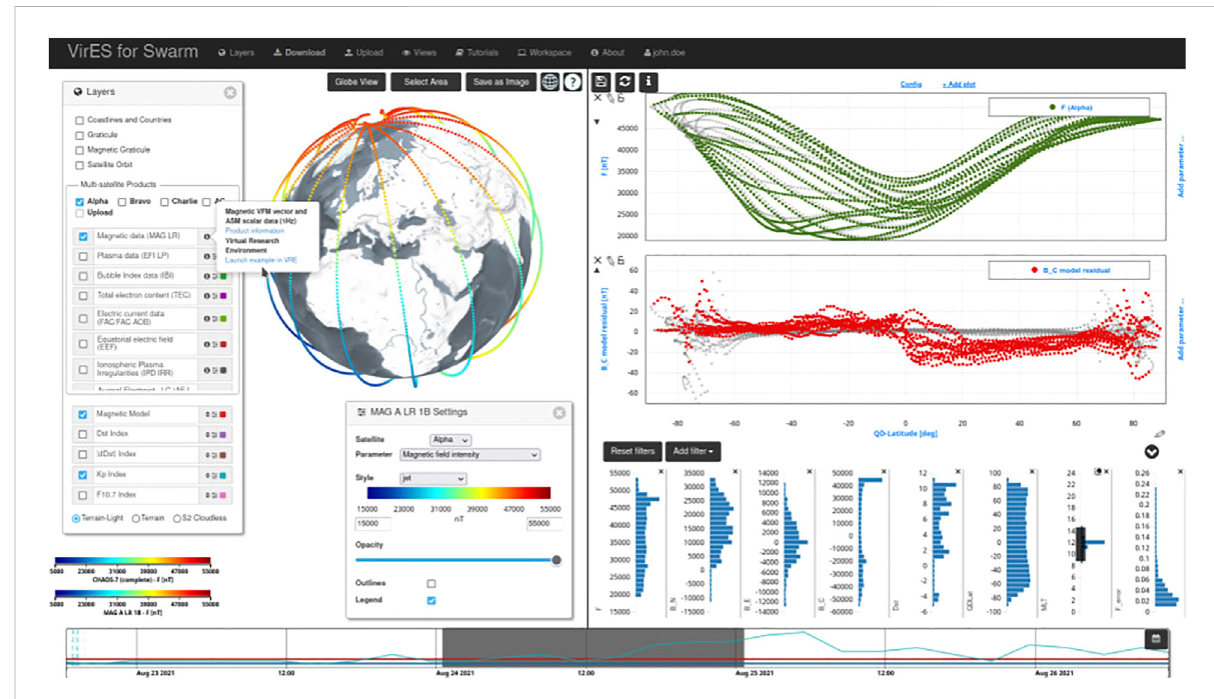
FIGURE 1 VirES web interface (https://vires.services): The layers panel on the left allows selection of multiple datasets together; the time slider on the bottom selects the time period of interest; a globe view and an “ analytics ” view can be used together to generate both 3D and 2D visualizations.